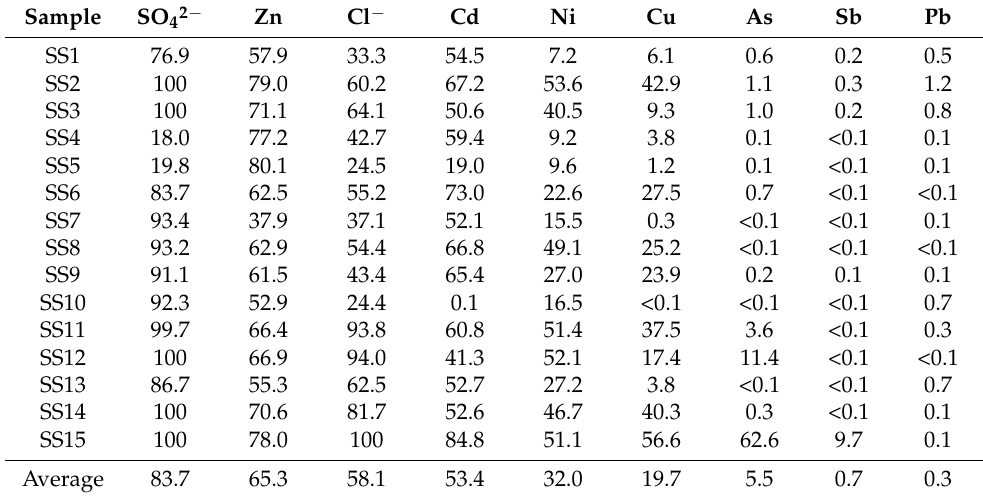
Table 4. Cations and anions enrichment factors percentage of the efflorescence salt leachates relative to nearby natural soils. Elements are presented in decreasing average